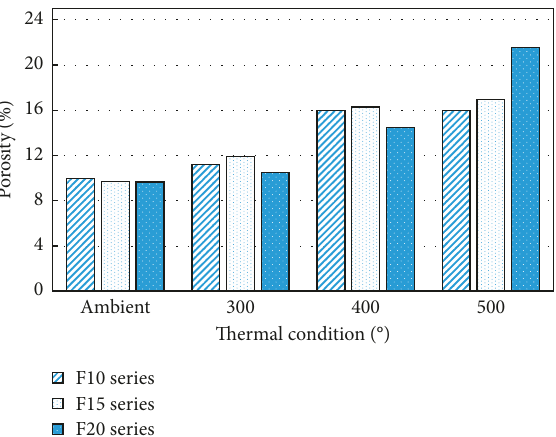
Figure 16: Porosity of the UHPC before and after exposure to high-temperature thermal